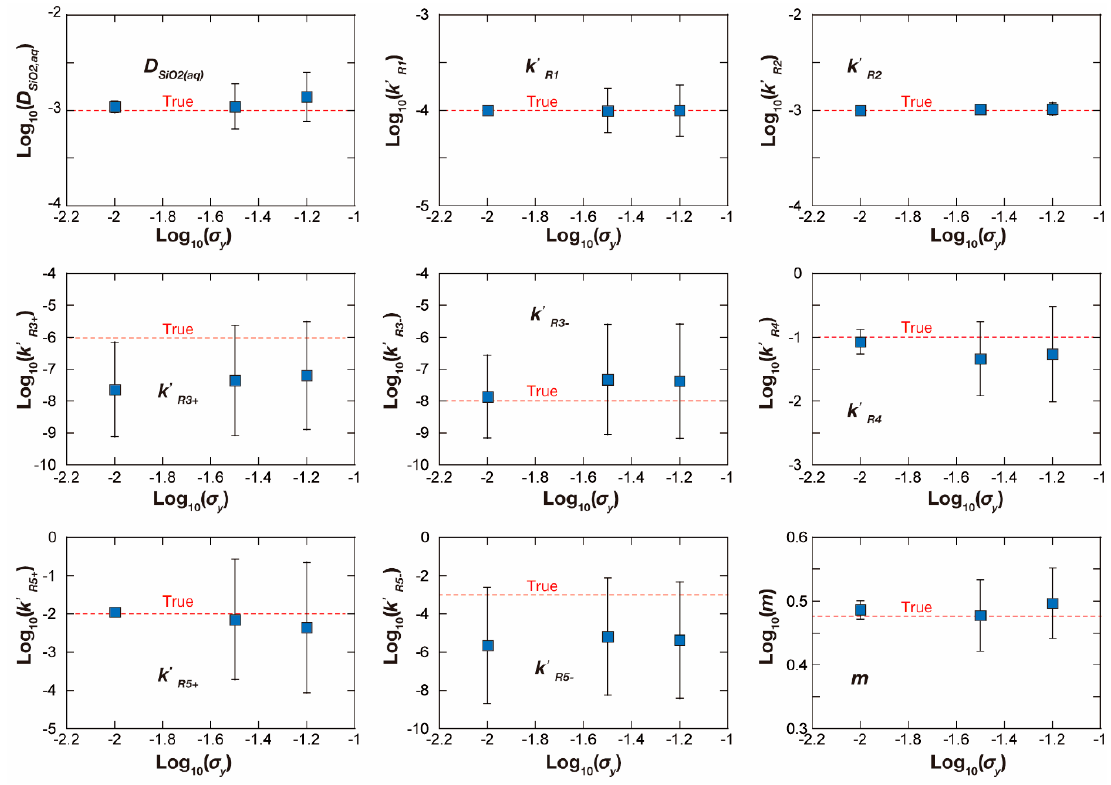
Figure 6. Noise effects on the accuracy of the estimated parameters. The dotted red lines show the true values of each parameter described in Section 3. The parameter errors are low when the observable noise ( σ y ) is low.